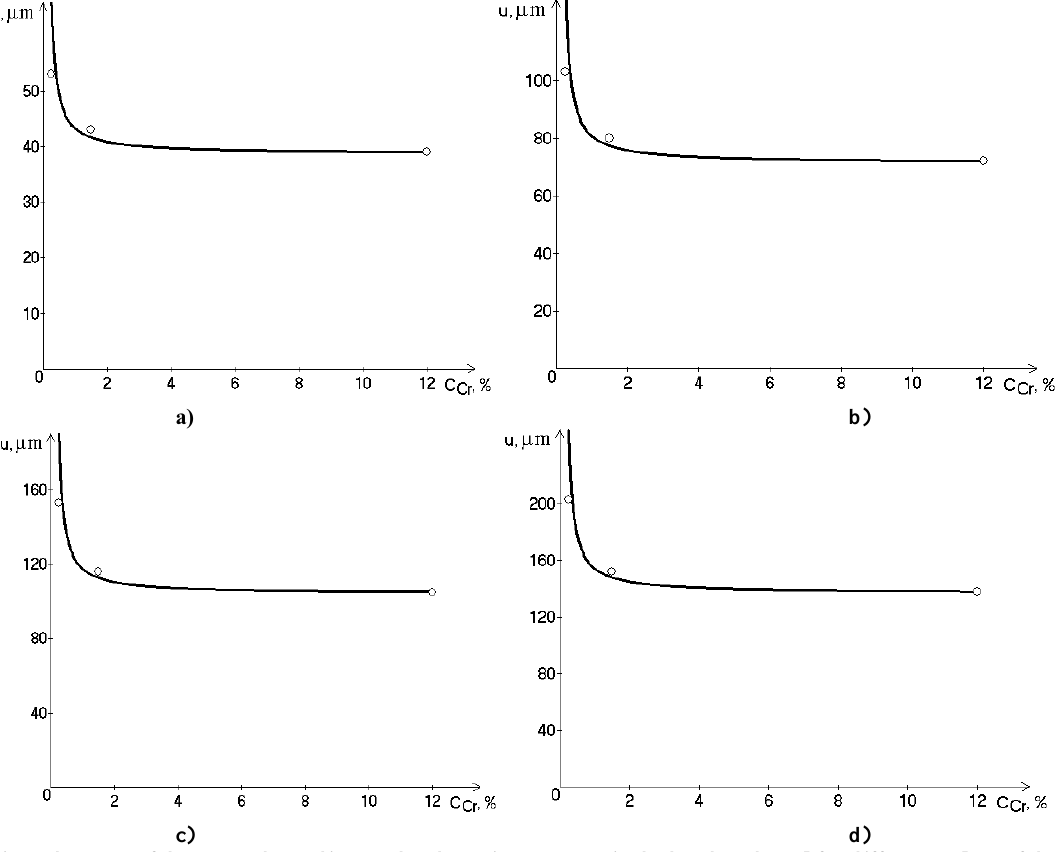
Fig.1 The wear of the auger depending on the chromium content in the hardened steel for different values of the friction path (а) – s = 3000 m, (b) – s = 6000 m, (c) – s = 9000 m, (d) – s = 12000 m: actual ○, theoretical